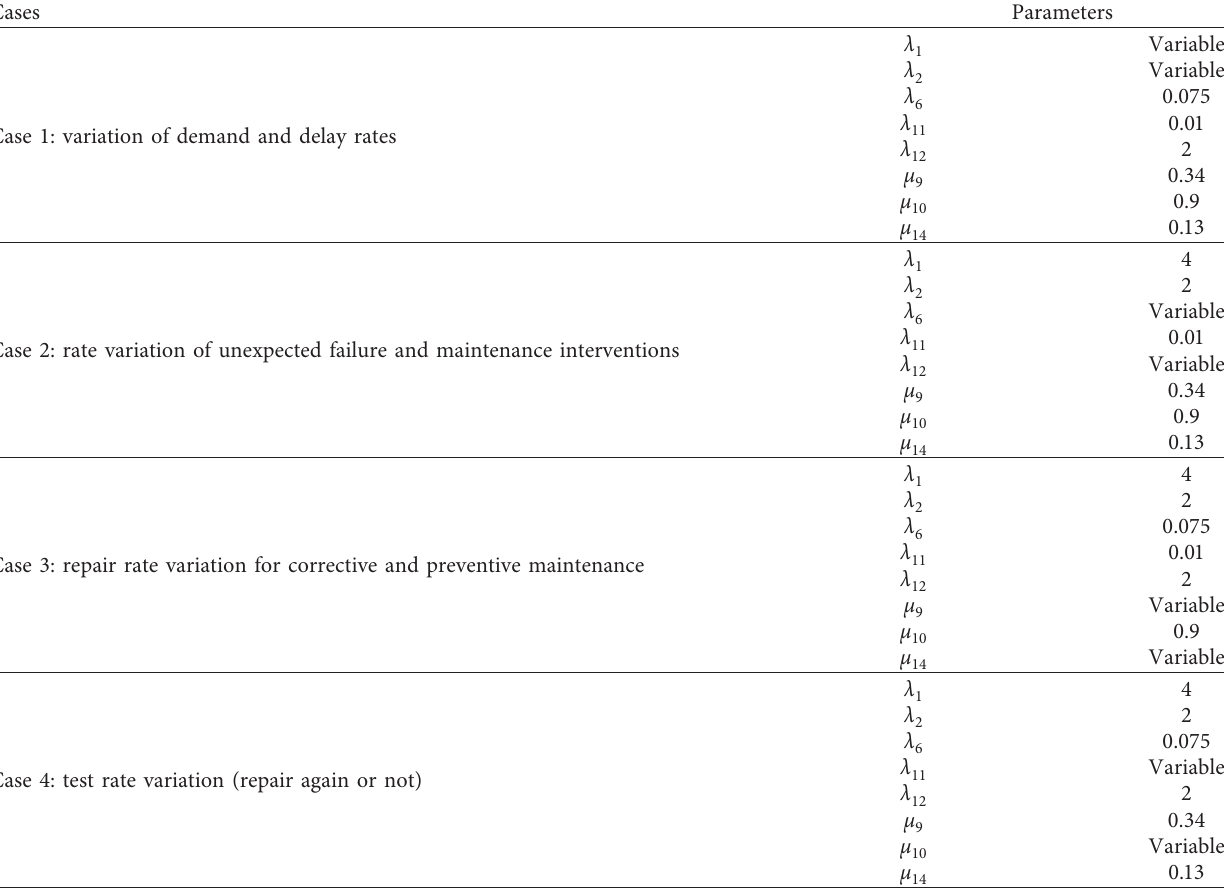
Table 4: The parameters considered in the analytical